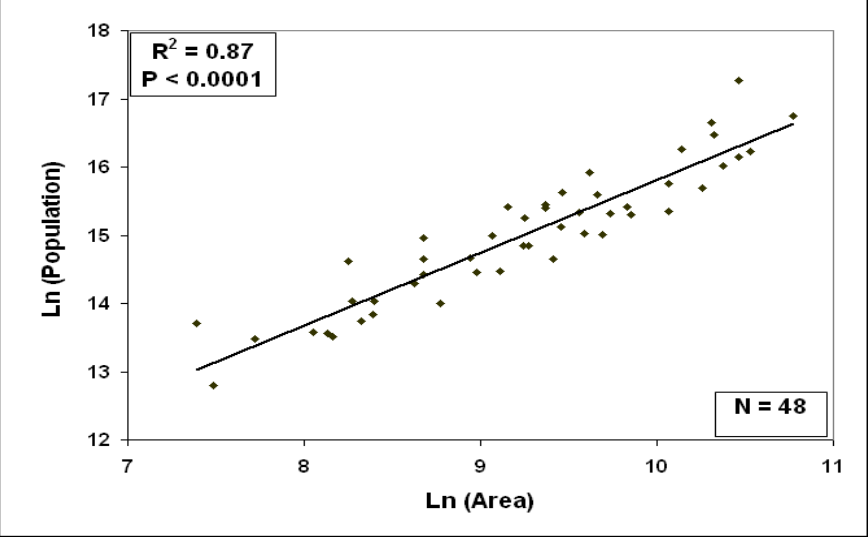
Figure 5. The log-log linear regression model of the area and population of the urban areas for the 48 contiguous U.S.